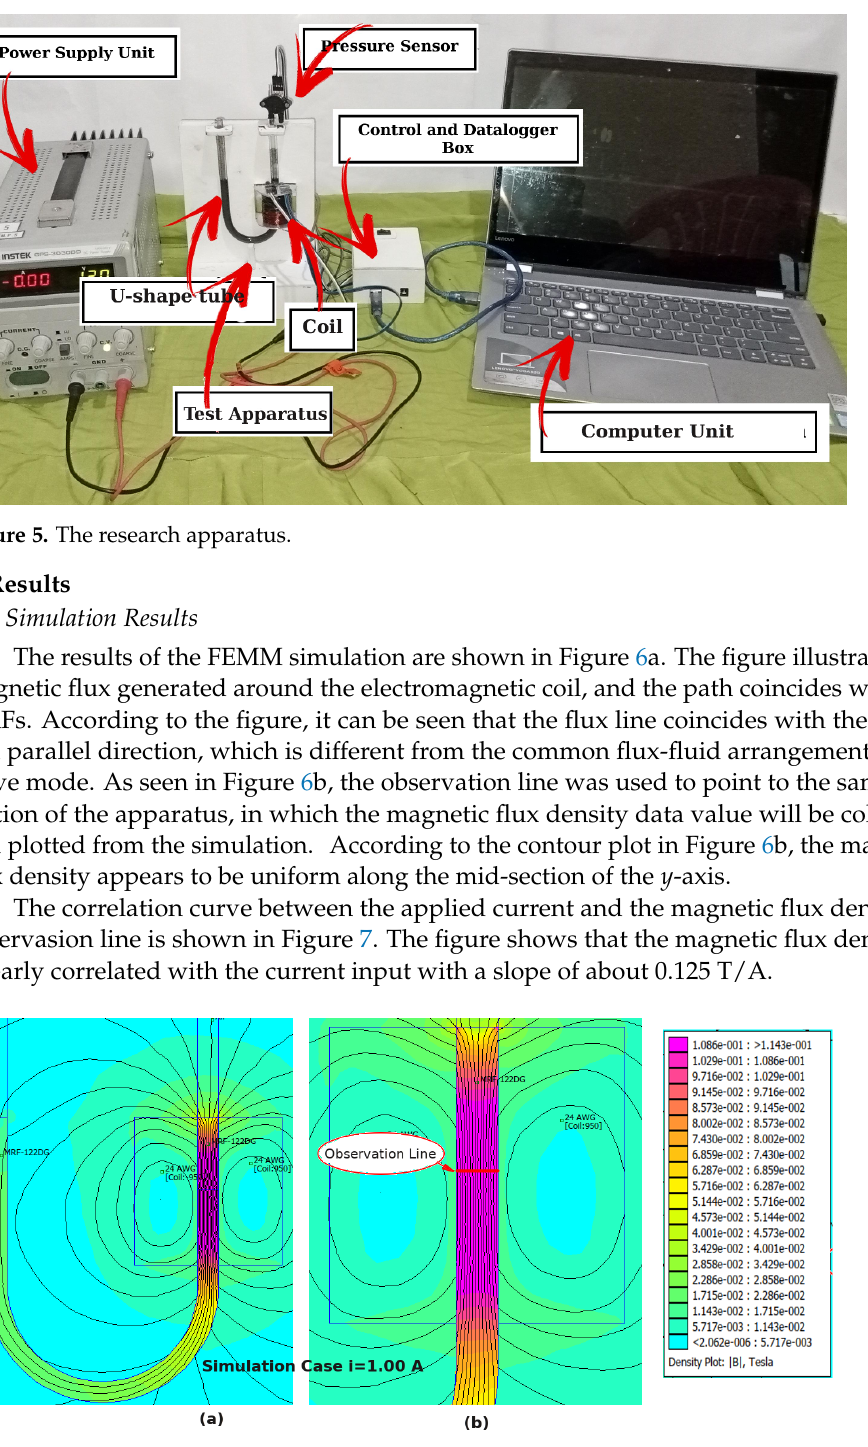
Figure 6. ( a ) Results of the FEMM software simulation (current input = 1 A); ( b ) The observation line that was used in the